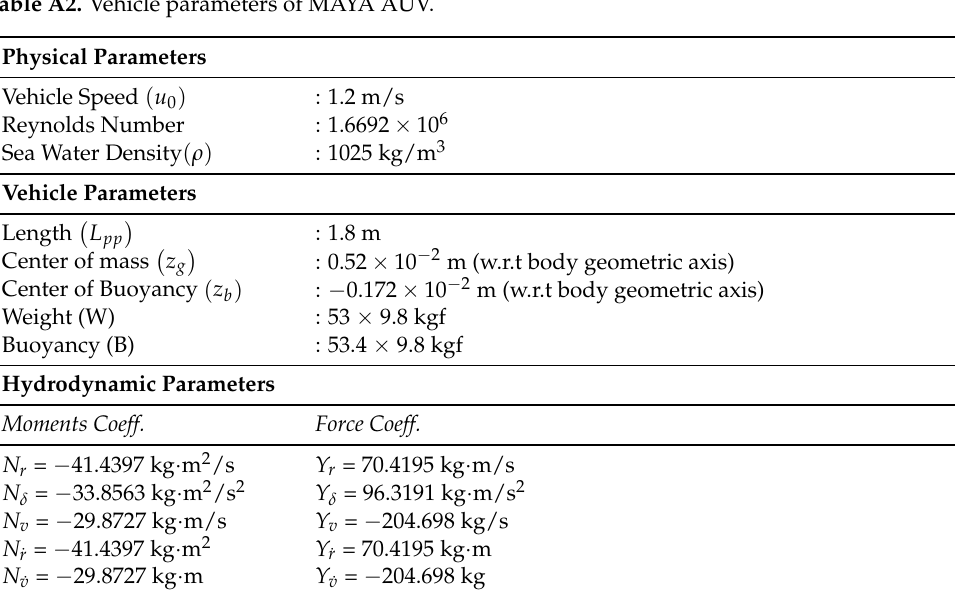
Table A2. Vehicle parameters of MAYA